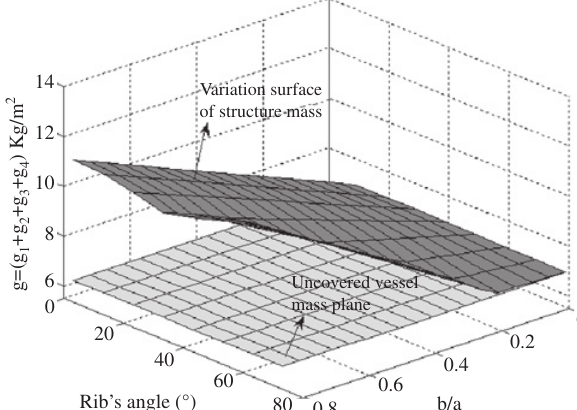
Figure 7 Variation of the structure mass with ϕ and ( b / a ) in comparison with the uncovered vessel mass under specified hoop constraint ε = ( 0.5%). y